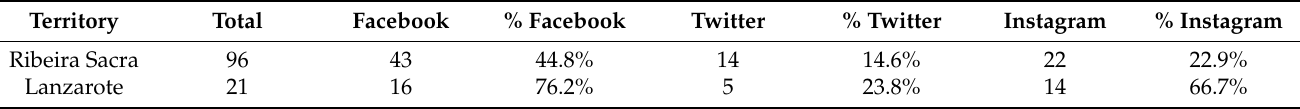
Table 5. Presence of social media in wineries of the Ribeira Sacra and Lanzarote